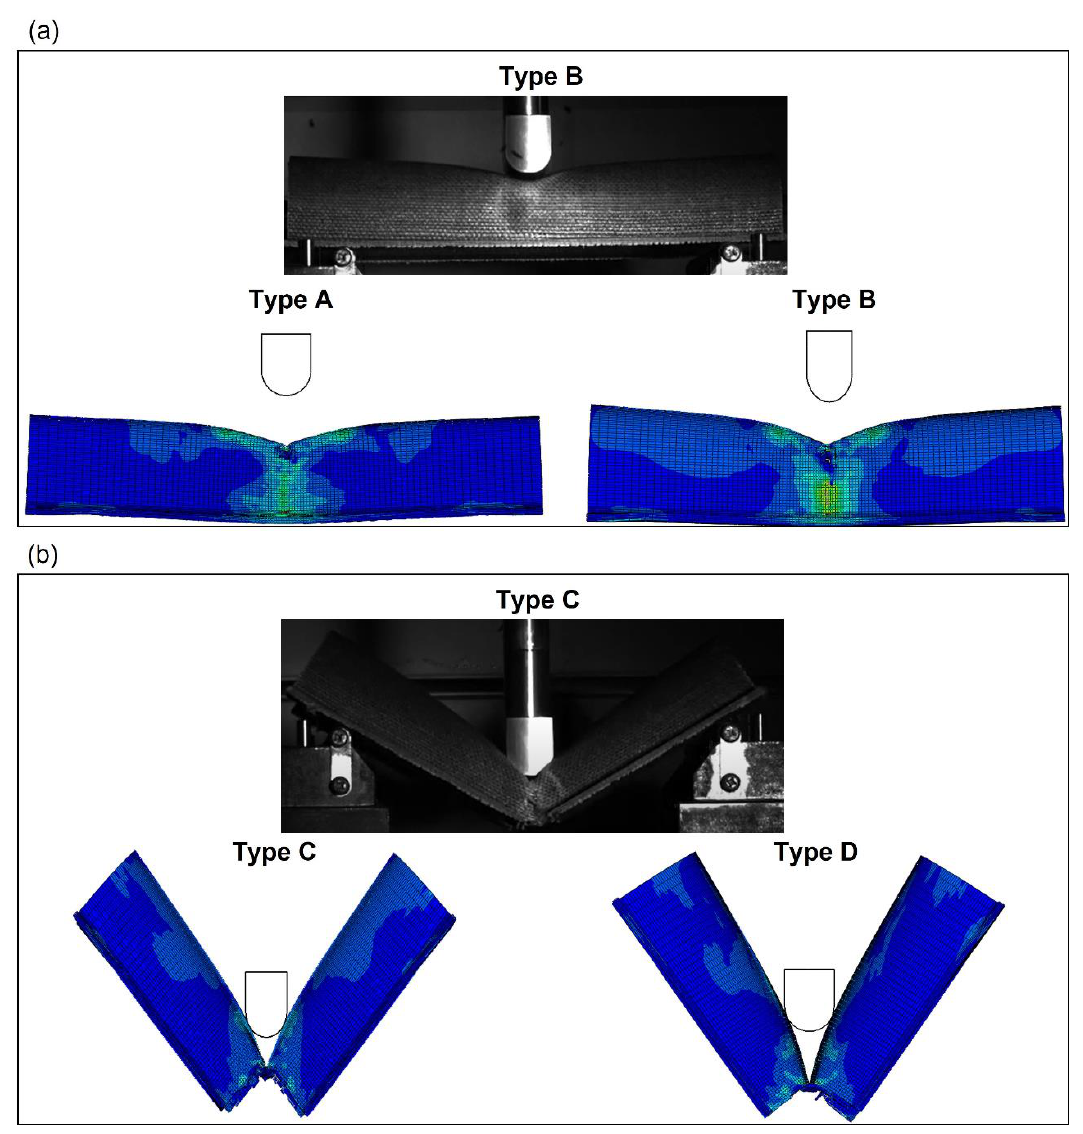
Figure 17. Side view of the bumper beams impacted at 60 J. ( a ) Photograph of Type B and numerical screenshots of Type A and B; ( b ) photograph of Type C and numerical screenshots of Type C and D.